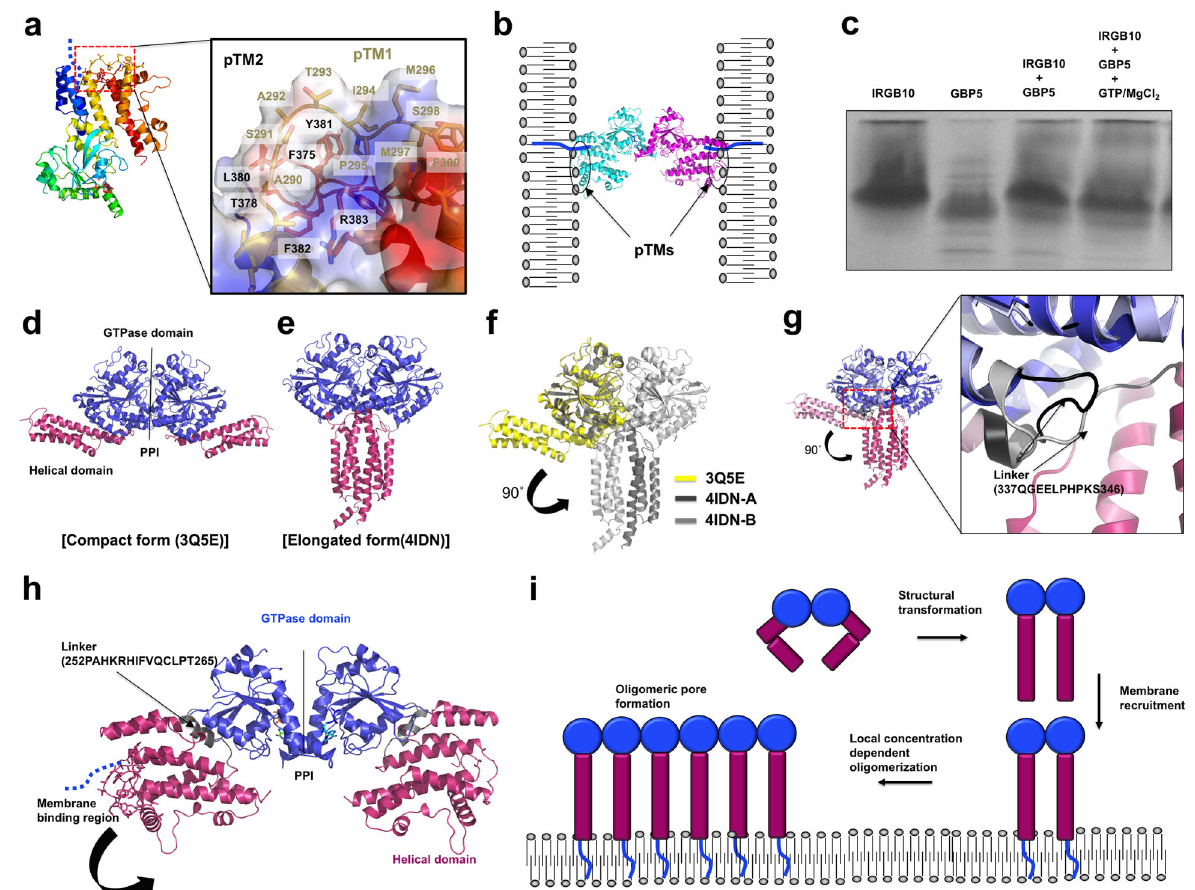
Fig. 5 Putative model of IRGB10 oligomerization-mediated membrane disruption. a The putative membrane-bound regions of IRGB10. The blue dotted line indicates the N-terminus region where myristoylation occurs. The close-up view in the panel on the right shows the two putative IRGB10 transmembrane regions (pTMs). The close-up view of this area is shown in a panel on the right. pTM1 and pTM2 indicate putative transmembrane regions 1 and 2, respectively. The electrostatic surface is represented for a better view of the hydrophobic pTMs. b A tentative model of membrane binding by the dimeric IRGB10 via a myristoylated N-terminus and two transmembrane regions (pTMs). c Native-PAGE. The loaded protein samples are indicated above each lane. d The compact-form structure of human atlastin 1 (Atl1). The two distinct domains are colored differently, with the GTPase domain in deep blue, and the helical domain in dark pink. PPI stands for protein – protein interface. e The elongated structure of Atl1. The color code used in ( d ) also applies here. f Superposition between the compact form (indicated in yellow) and elongated form (in gray) of Atl1. g The structure of dimeric IRGB10. The color code used for ( d ) and ( e ) also applies here. h Concentration-dependent oligomerization of IRGB10. The pro fi le of SEC FPLC is provided. i Putative model of IRGB10 oligomerization via structural change and the resulting membrane (Fig. 5e, f). This structural rearrangement of Atl1 is mediated by the linker region (residues 337 – 346) located between the GTPase